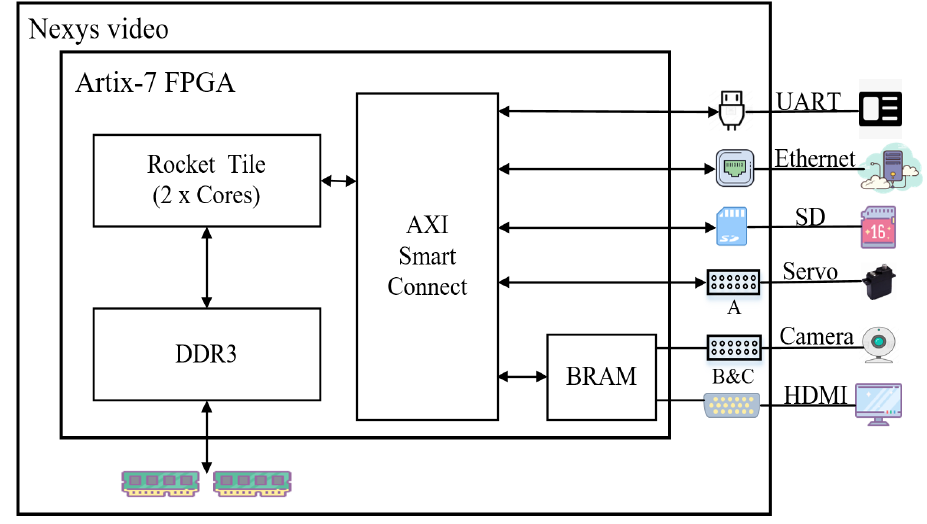
Figure 2. System hardware